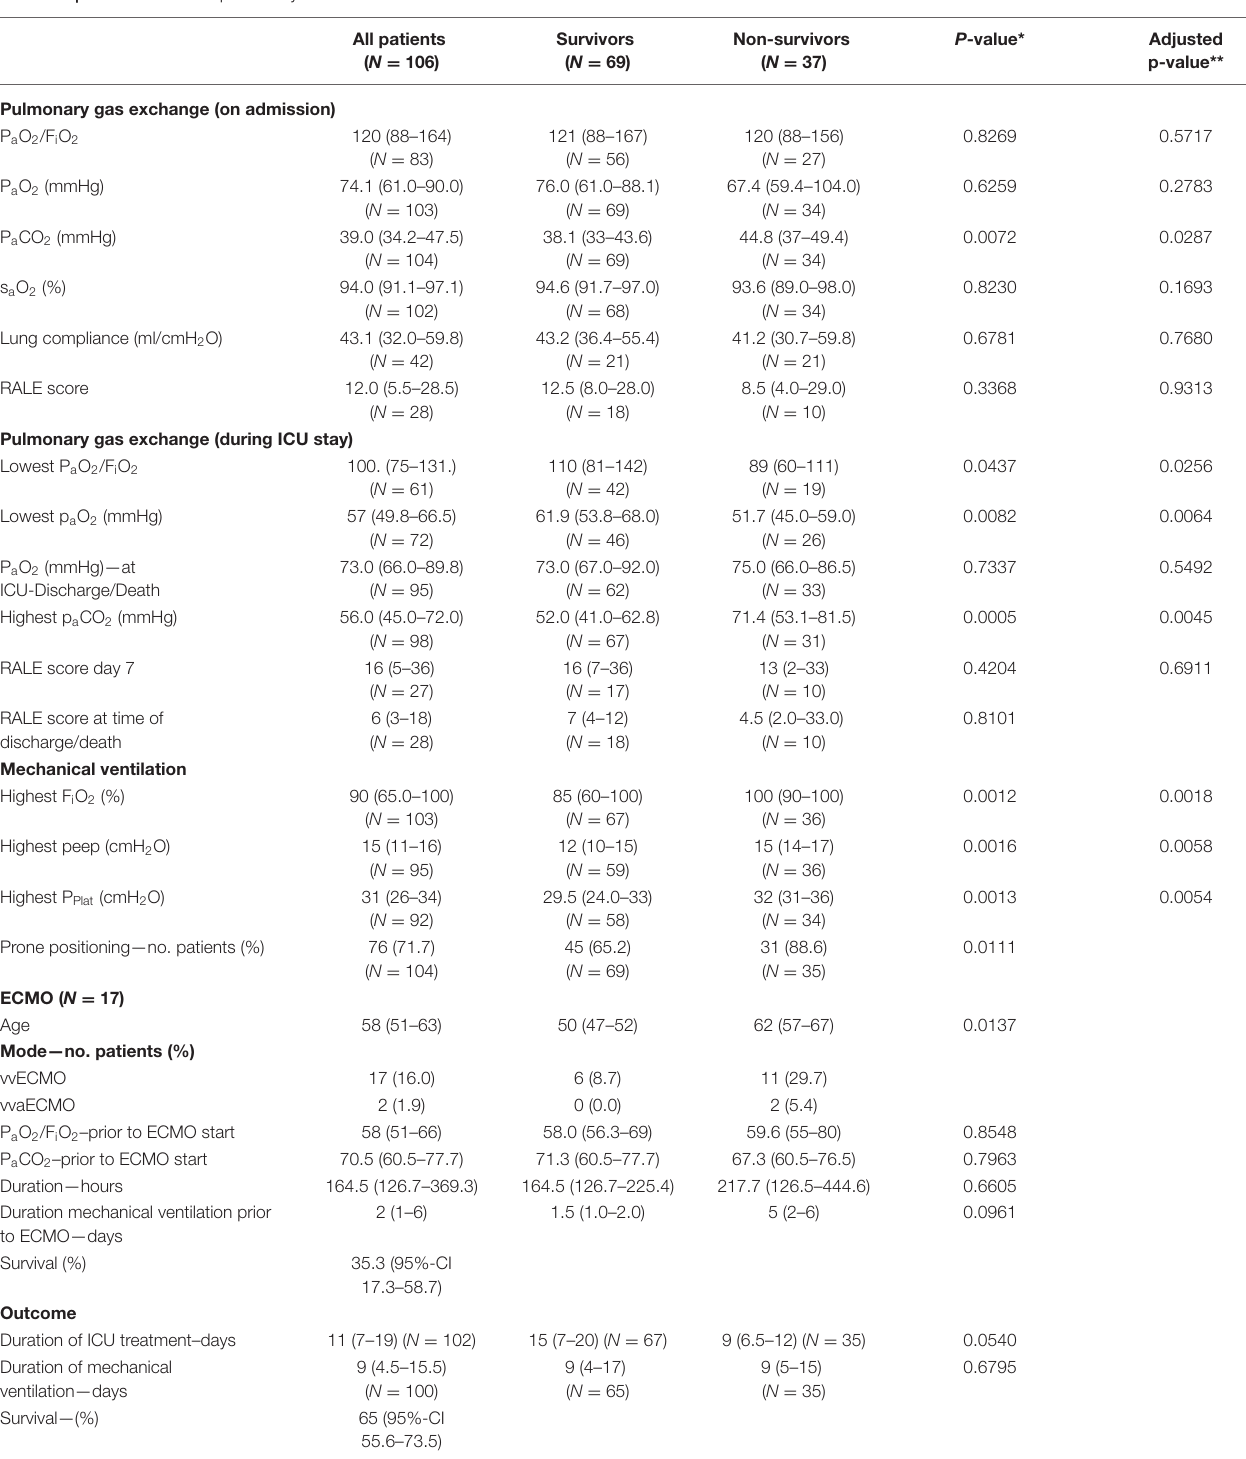
TABLE 3 | Characteristics of pulmonary function and outcome.